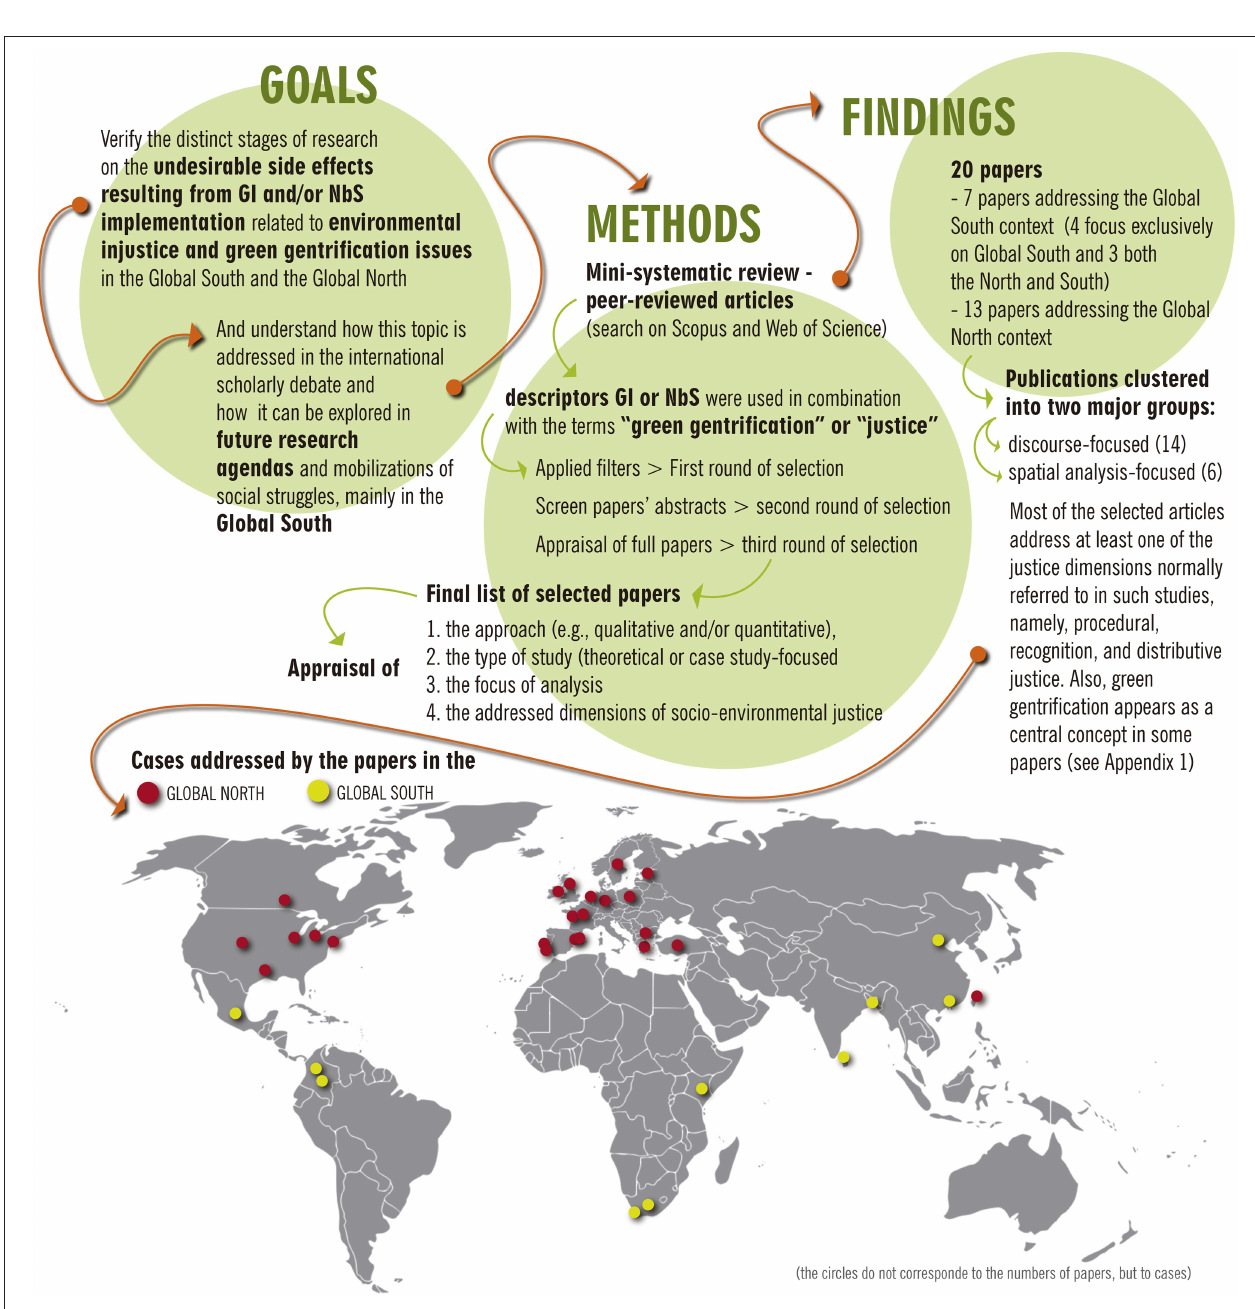
justice issues and the implementation of an urban green agenda in the South is still in its initial stage in the international